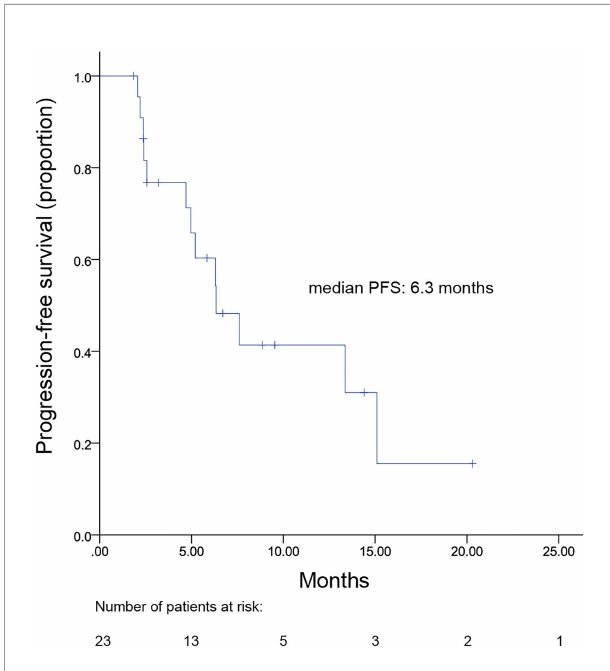
FIGURE 4 | Kaplan – Meier plot for progression-free survival of patients with brain metastasis.